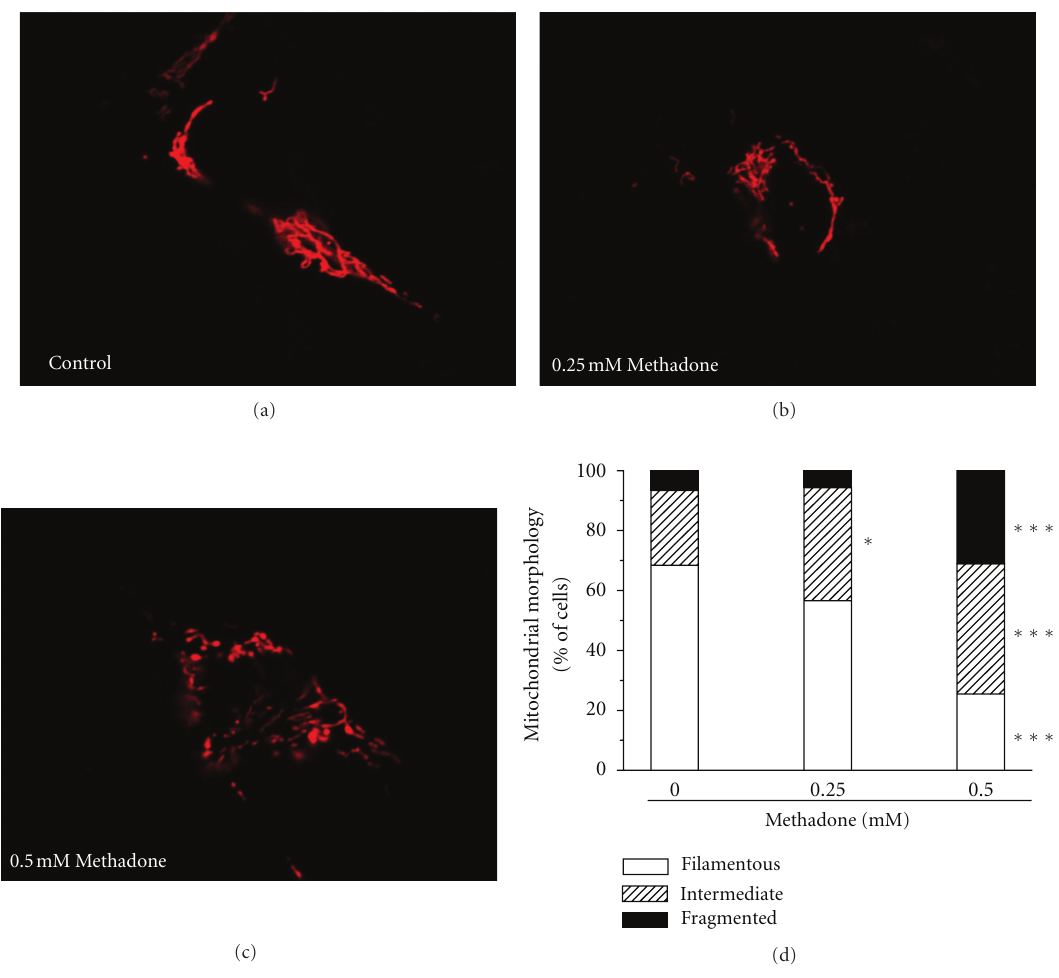
Figure 2: Methadone alters mitochondrial morphology. Morphology of methadone-treated cells was studied by confocal imaging of SH- SY5Y cells transfected with the pDsRed2-mito vector. Twenty-four hours after transfection, cell cultures were incubated for 3h in the absence or presence of 0.25 or 0.5 mM methadone. Shown are images of the representative mitochondrial morphology in non-treated cells (control, (a)) or cells treated with methadone ((b), 0.25 mM; (c), 0.5 mM). Scale bar indicates 10 μ m. (d), The fractions of cells with filamentous, intermediate or punctuate mitochondrial patterns were determined in at least 6 independent cultures. ( ∗ P < 0 . 05; ∗∗∗ P < 0 . 001; Student’s t -test versus basal conditions as